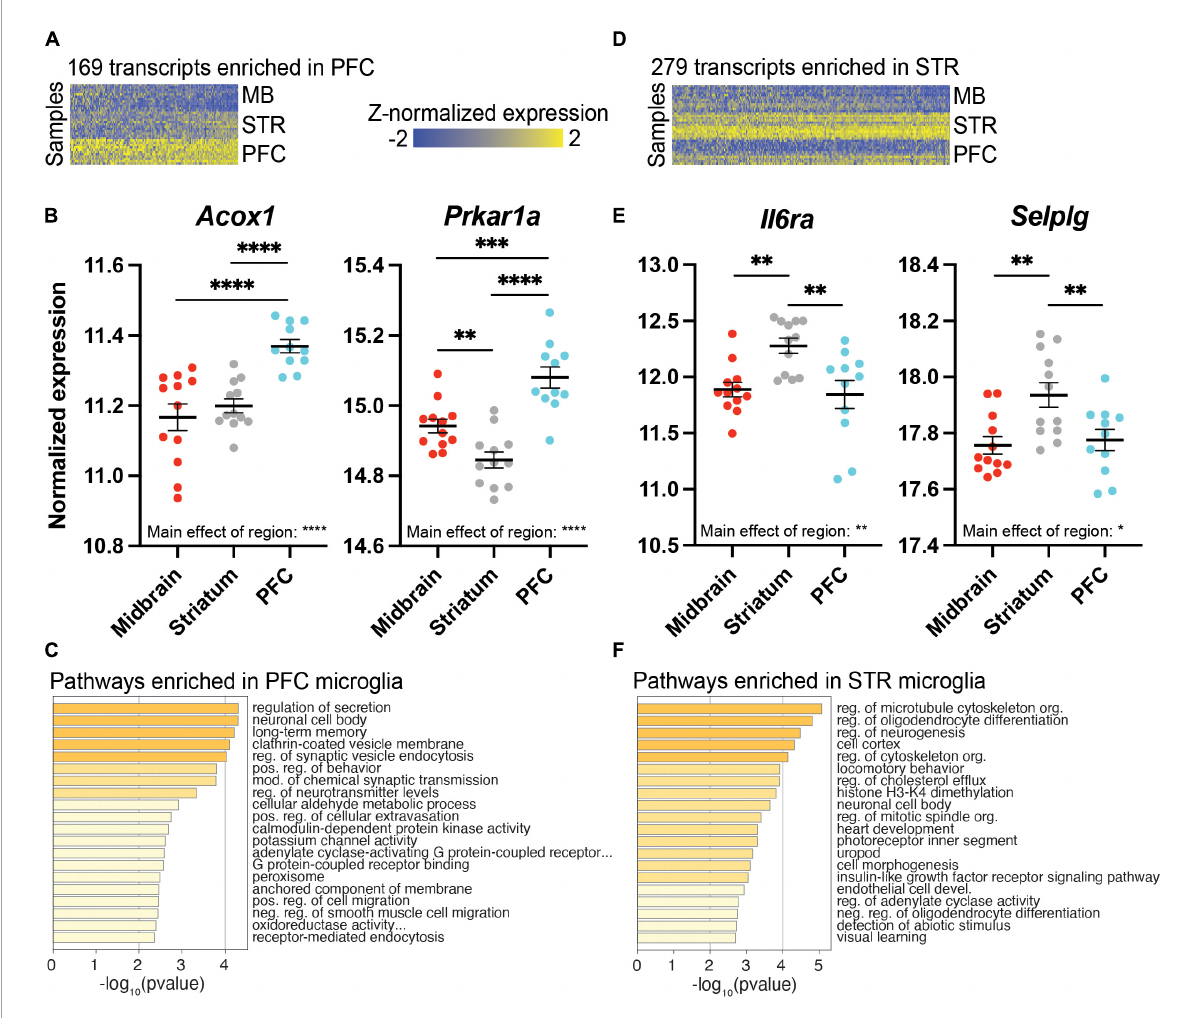
FIGURE4 Differentially expressed (DE) transcripts enriched in prefrontal cortex (PFC) or striatum (STR). (A) Heatmap of 169 DE transcripts between PFC and both STR and midbrain (MB). DE transcripts are plotted on the x-axis and individual subject samples on the y-axis. (B) Acox1 and Prkar1a fit the pattern of being more highly expressed in PFC compared to STR and MB. (C) Top pathways represented by transcripts expressed more highly in the PFC compared to STR and MB. (D) Heatmap of 279 transcripts enriched in STR compared to both PFC and MB. (E) Il6ra and Selplg fit the pattern of being more highly expressed in the STR compared to PFC and MB. (F) Top pathways represented by transcripts enriched in STR compared to PFC and MB. ∗ , p < 0.05; ∗∗ , p < 0.01; ∗∗∗ , p < 0.001; ∗∗∗∗ , p <